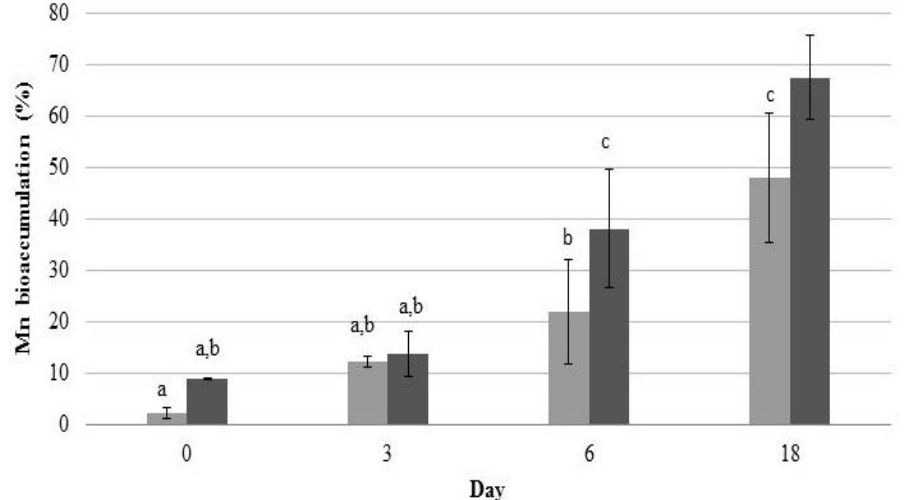
Figure 5. Mn accumulation in cells of the 2De strain during accumulation studies with 0.5 M MnO 2 (light grey column) and 4% soil from the metallurgical waste heap (dark grey column). Error bars are standard deviation (n = 3).